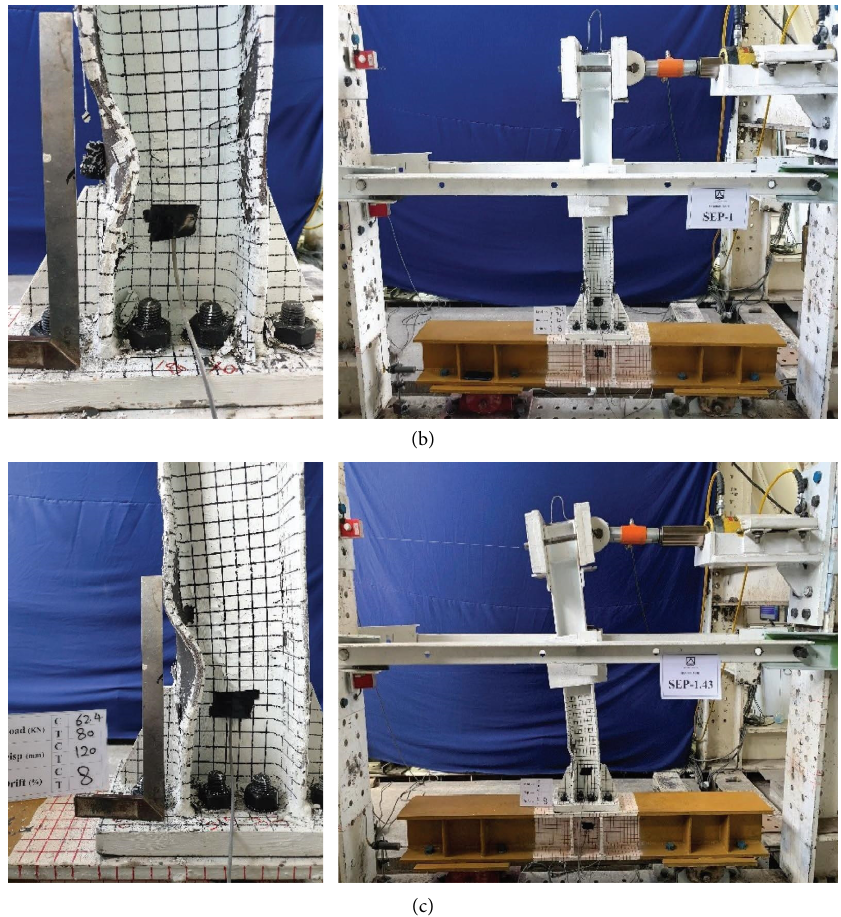
Figure 7: Specimens at the end of loading. (a) SEP-0.00. (b) SEP-1.00. (c)